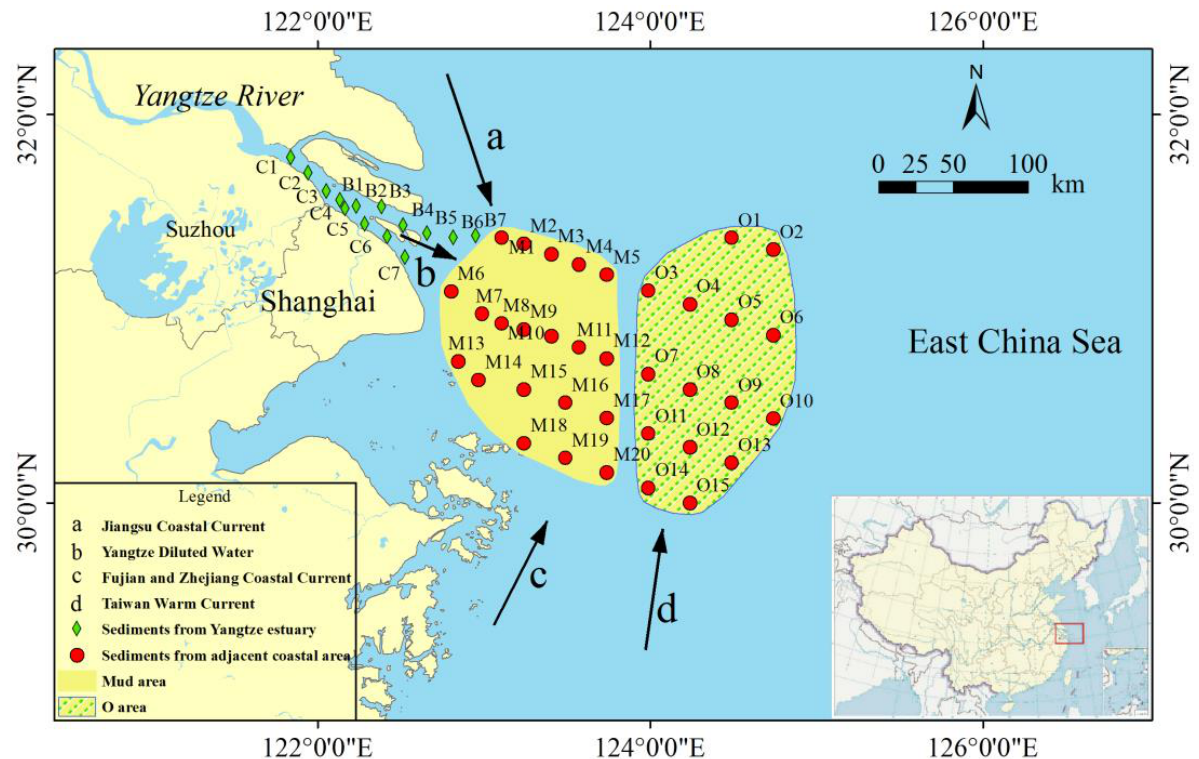
Figure 1. Sampling sites in the estuary of the Yangtze River and its coastal area (mud areas are modified according to Liu et al. 2007 [26].